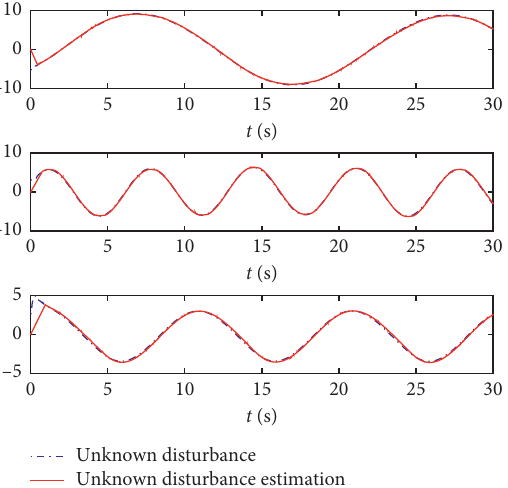
Figure 17: Unknown disturbance and its estimation on FTUO-